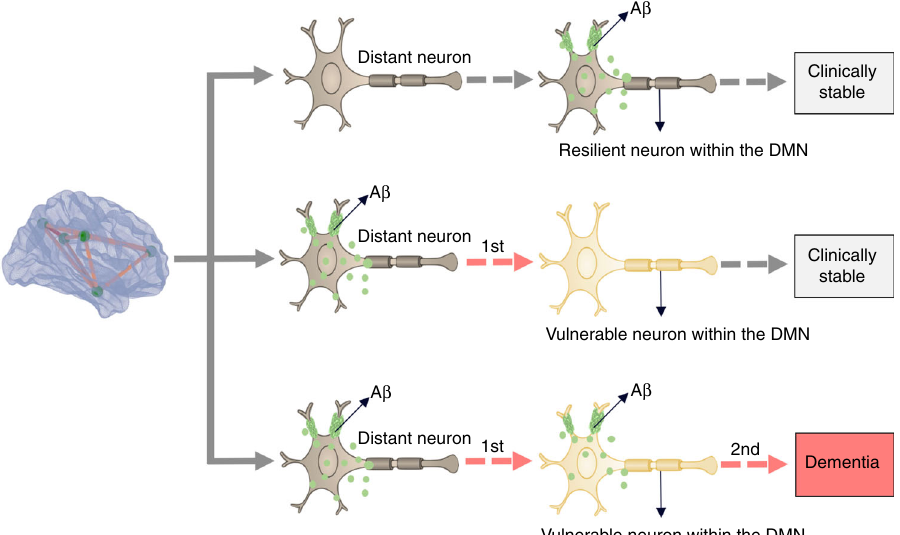
Fig. 8 Schematic representation of the distant and local amyloid- β (A β ) effects on metabolism. A β from distant brain regions leads to regional metabolic vulnerability, whereas the synergy between this vulnerability with local A β effects drives the clinical progression of dementia. Importantly, either A β